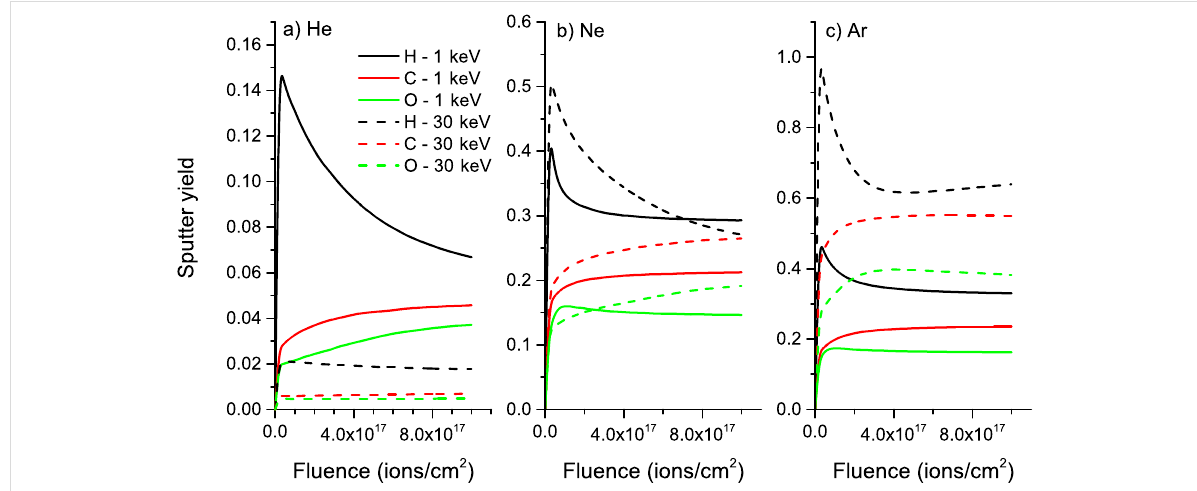
Figure 9: Evolution of sputter yields with fluence for a) helium, b) neon, and c) argon bombardment of PMMA at 1 keV and 30 keV.